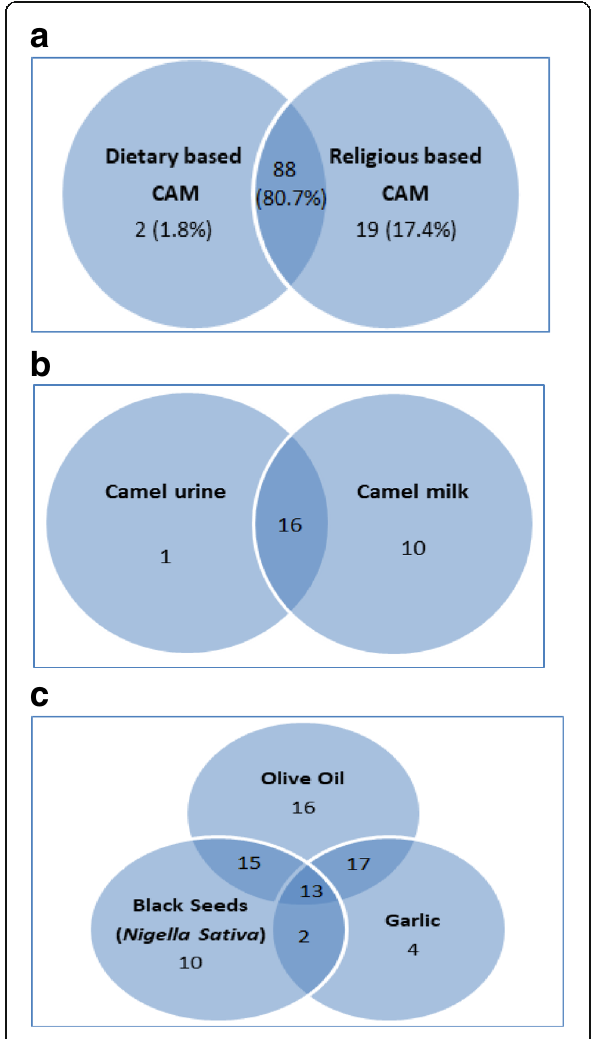
Fig. 1 Venn Diagrams demonstarting overlapping usage of different types of complementary and alternative medicine (CAM). Dietary vs.religious based CAM use ( a ); camel product users tend to use both ( b ); dietary based CAM overlap ( c